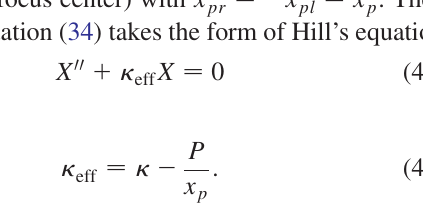
TABLE I. Sheet-beam rms equivalency with ~ x ¼ x (cid:1) h x i and ~ x 0 ¼ x 0 (cid:1) h x 0 i